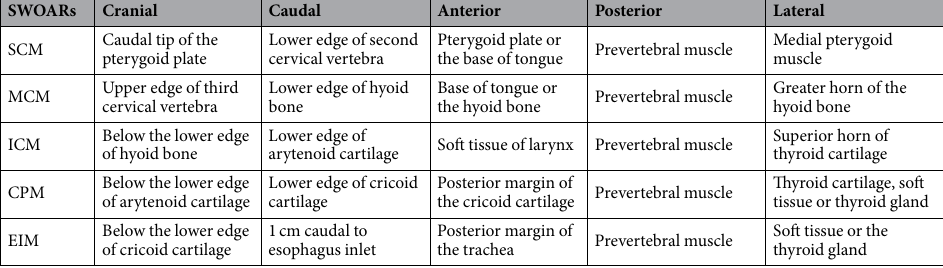
Table 1. Anatomic borders of the SWOARs. Abbreviations: SCM: the superior constrictor muscle, MCM: the middle constrictor muscle, ICM: the inferior constrictor muscle, CPM: cricopharyngeus muscle, EIM: esophagus inlet muscle, cm =